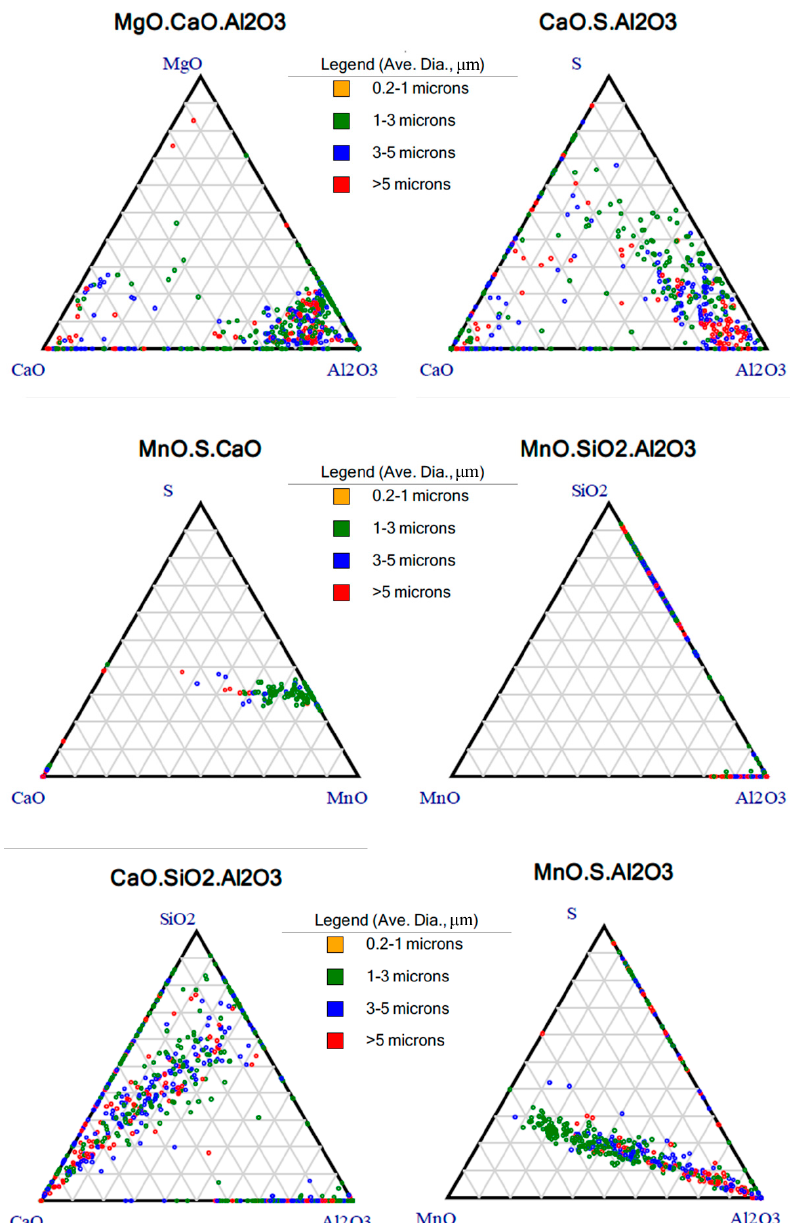
Figure 6. Ternary phase composition of the inclusions of 20Cr2Ni4 steel.